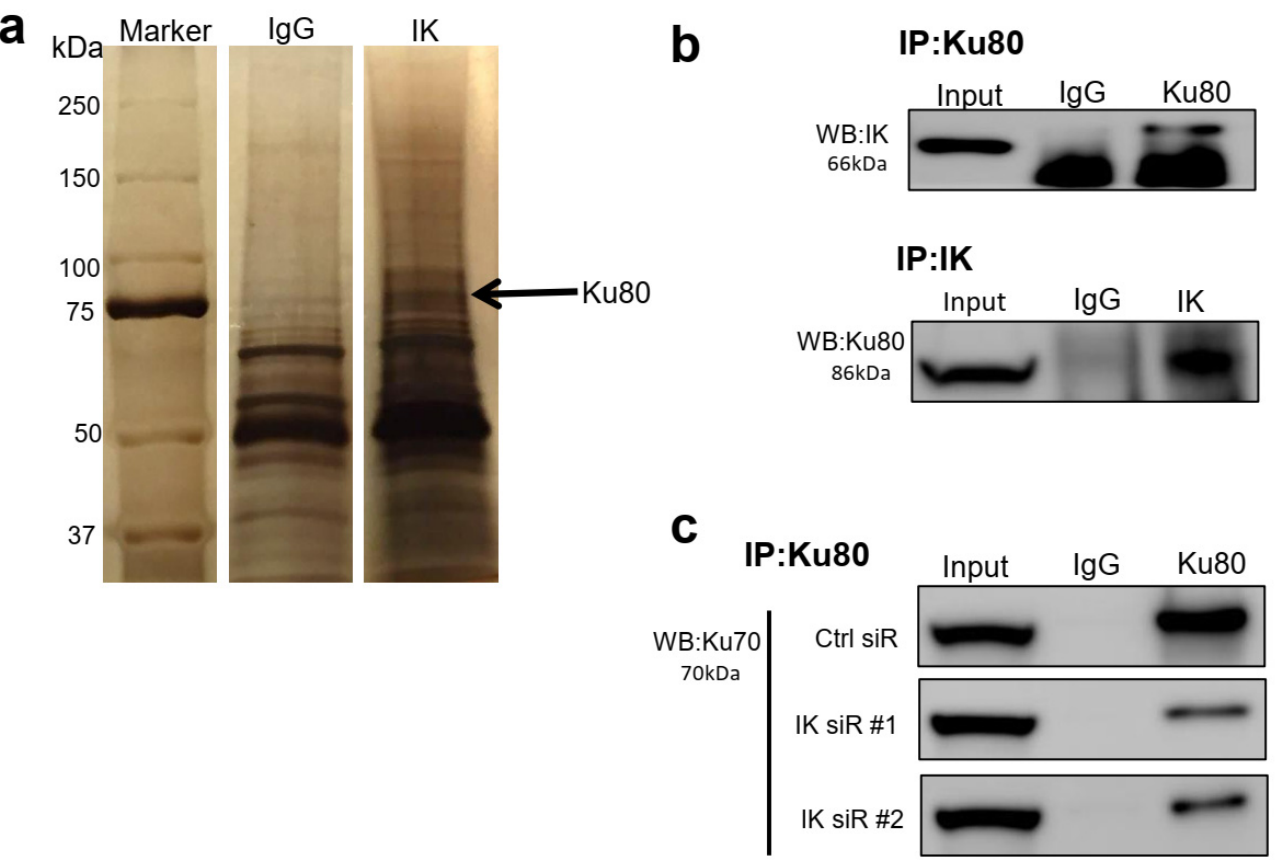
Figure 3. IK interacts with Ku80 and modulates Ku80 complexing with Ku70. ( a ) After DNA-damaging treatment (10 µM cisplatin for 1 h), proteins from IP experiments were analyzed by SDS-PAGE and silver stained. ( b ) After cisplatin treatment, Ku80 directly interacted with IK. ( c ) Seventy-two hours after IK siRNA transfection with cisplatin treatment, IK attenuation weakened Ku80 complexing with Ku70.